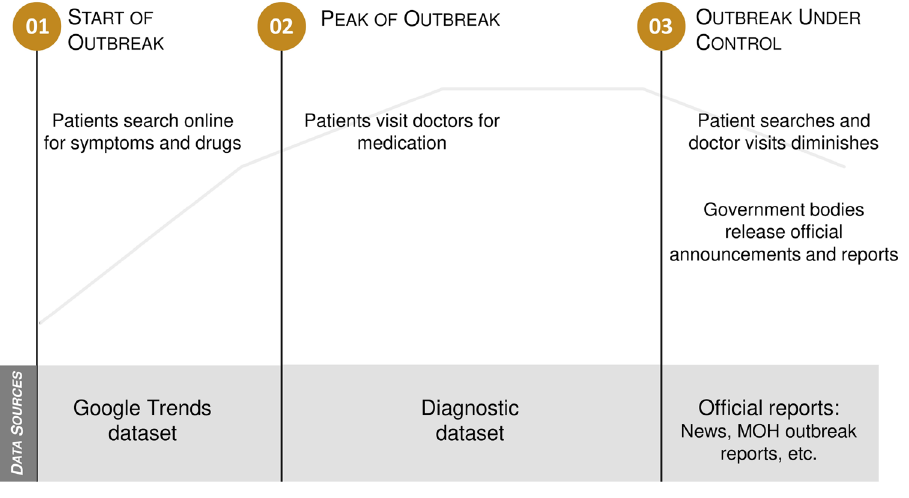
Figure 11. A typical outbreak